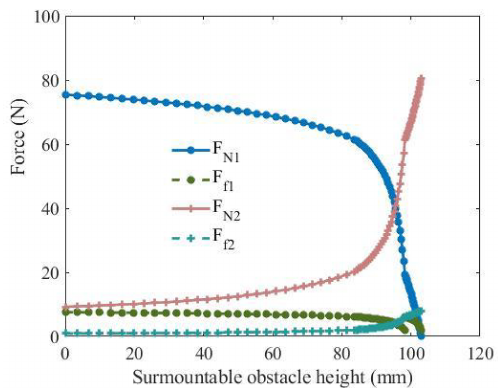
Figure 11. The variation of force during